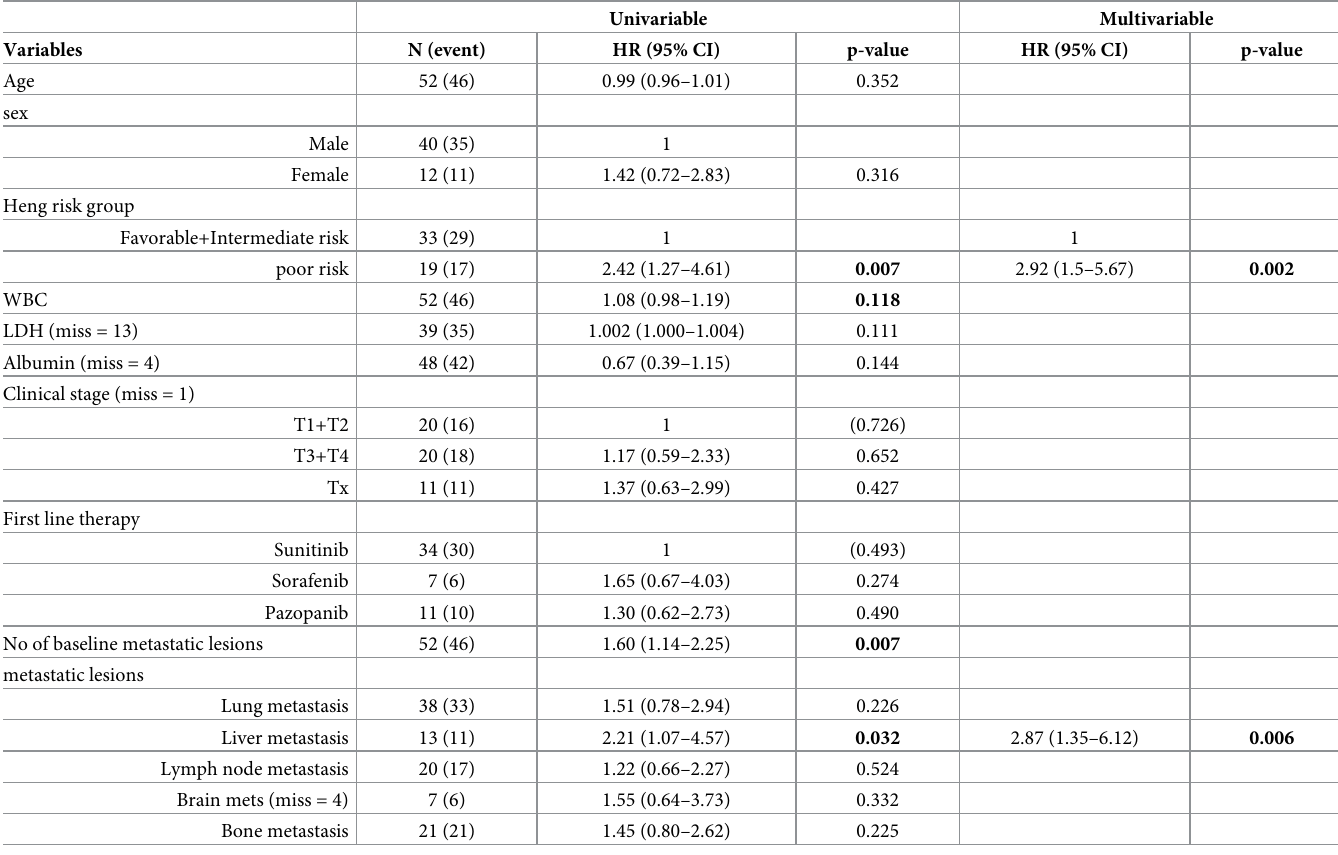
Table 4. Cox regression analysis of the prognostic factors for progression-free survival in treated TKI only patients